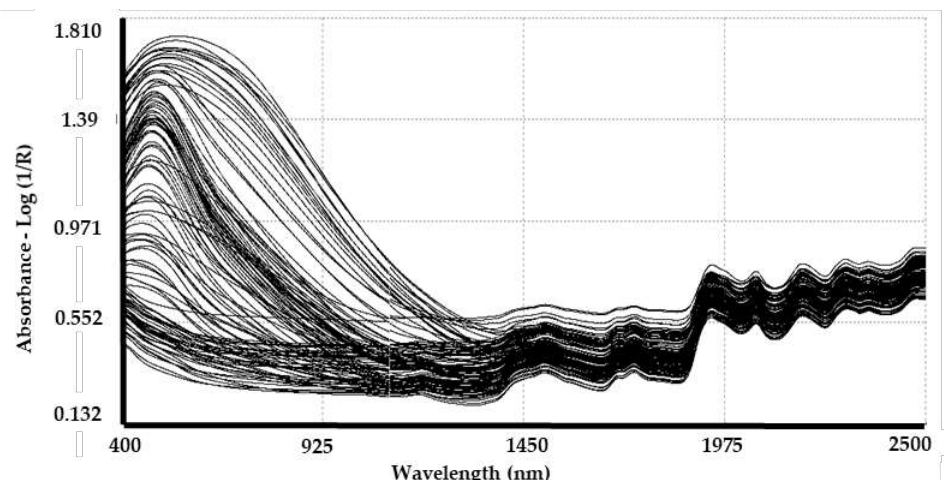
Figure 2. Visible and near infrared reflectance from raw spectra of all samples. Axis: absorbance (log 1/R) vs. VIS–NIR wavelength (400–2500 nm).